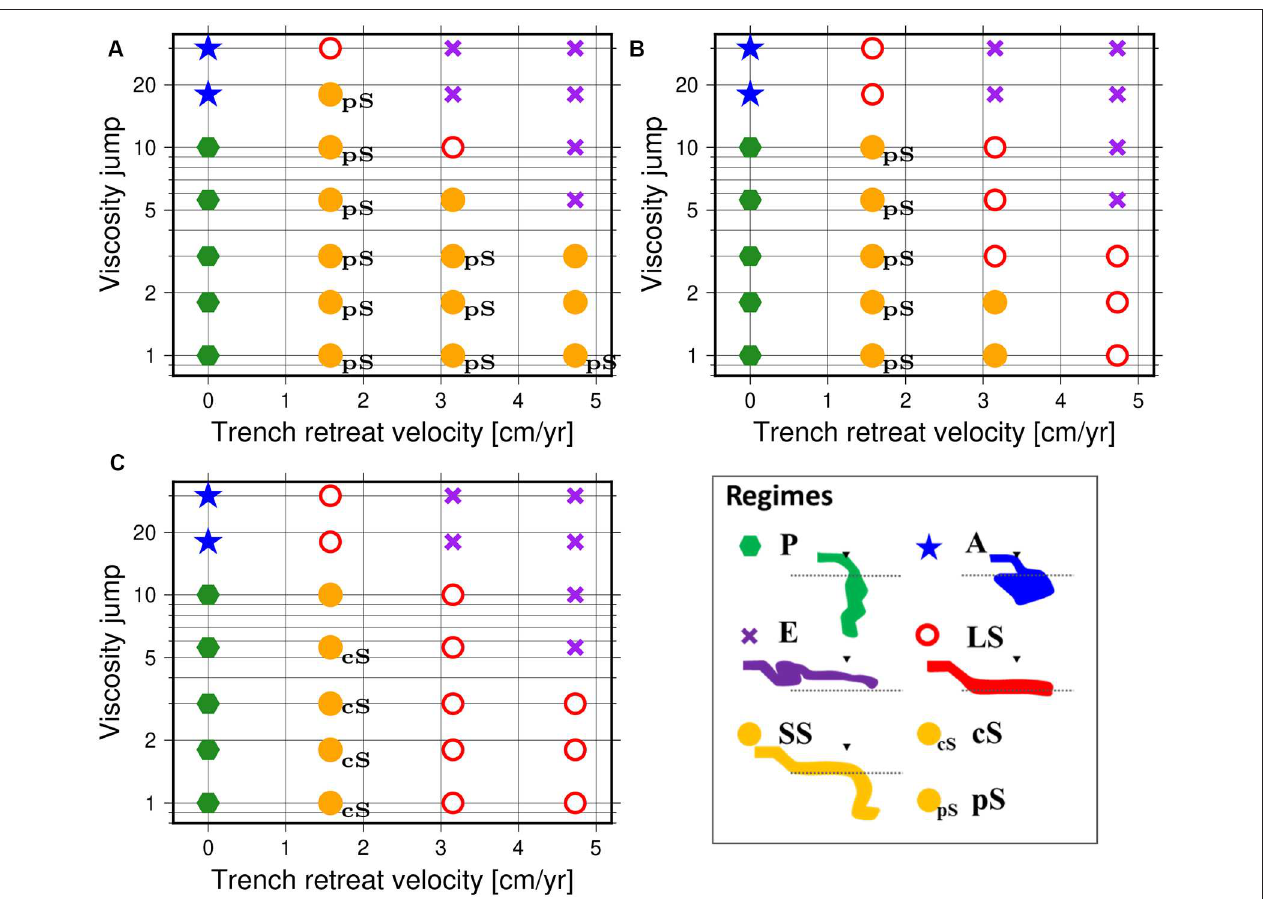
FIGURE 4 | Regime diagrams of the slab morphologies as a function of trench retreat velocity v tr and viscosity jump r η for the cases of (A) γ 660 γ 660 2 MPa/K, and (C) γ 660 -3 MPa/K. The types of Penetration (P), Accumulation (A), Entrainment (E), Long-term Stagnation (LS), and Short-term Stagnation = − = (SS) are represented by green hexagons, blue stars, purple crosses, red open circles, and orange filled circles, respectively. In addition, the types of stagnation after penetration (pS) and stagnation after collapse (cS) are represented by small letters of “pS” and “cS” in the right side of filled orange circles, respectively. In the schematic illustration of the regimes, the black triangles indicate the initial trench location, and the dashed lines indicate the 660 km